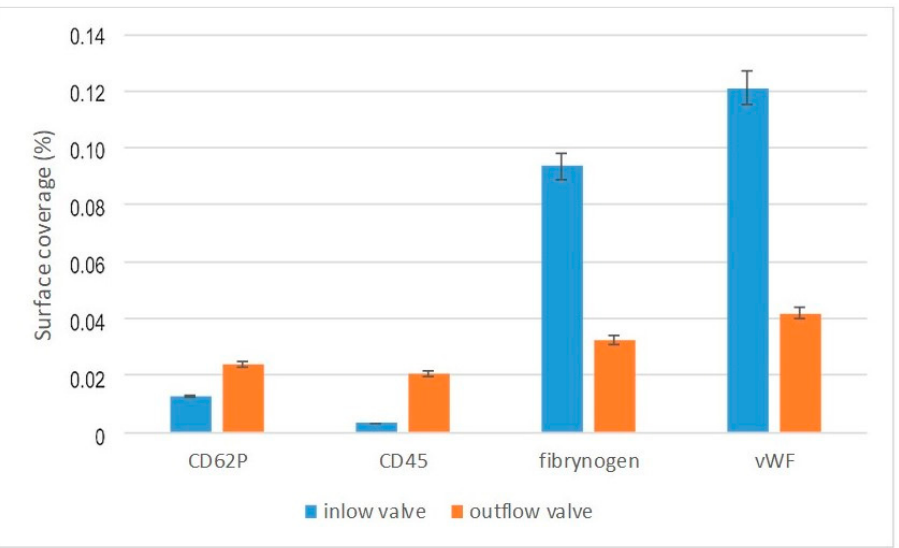
Table 1. Comparison of hemolysis of pulse pumps with the tested valves and hemolysis of reference pumps. Type of Blood